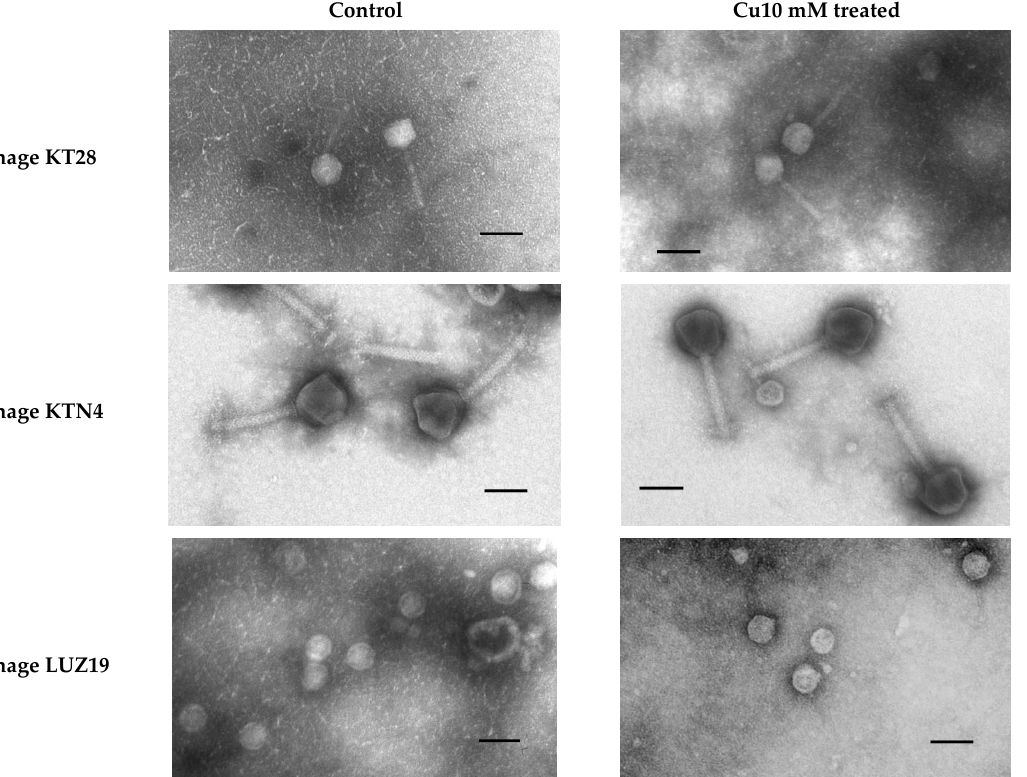
Figure 5. TEM electrographs of phages after 4 h incubation with Cu 10 mM. Magnification 22,000×. Bars indicate 100 nm.